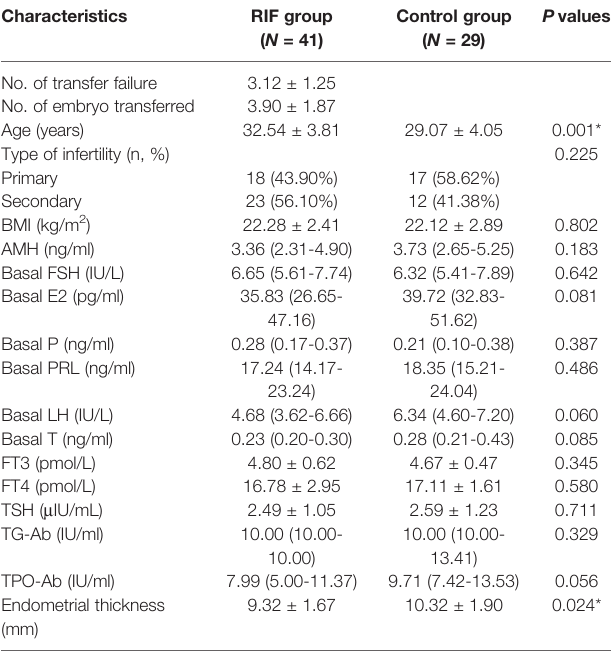
TABLE 1 | Baseline characteristics and related clinical indicators of the participants.